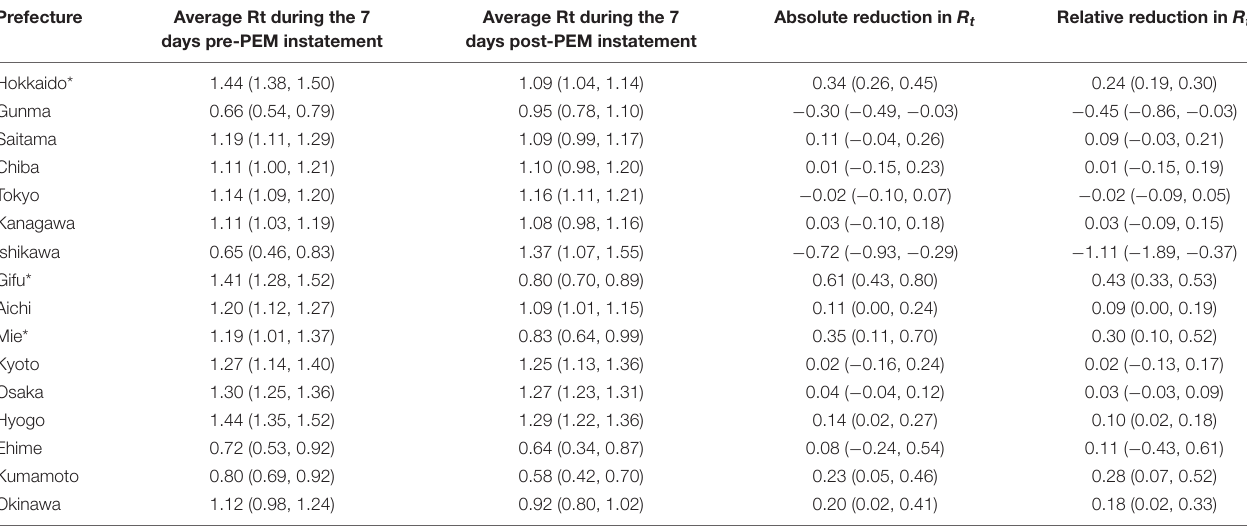
TABLE 1 | Effective reproduction number ( R t ) during the 7 days before and after pre-emergency measures (PEM) were instated. Prefecture Average Rt during the 7 Average Rt during the 7 Absolute reduction in R t Relative reduction in R t days pre-PEM instatement days post-PEM instatement